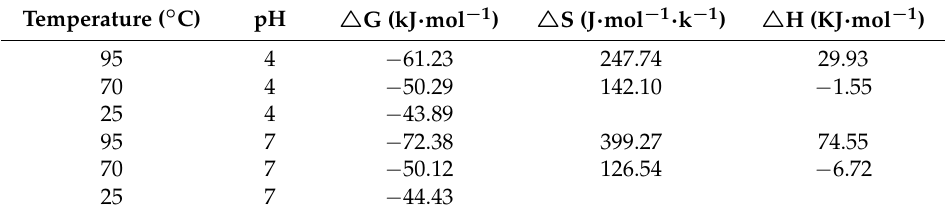
Table 3. The thermodynamic parameters for the binding of LF and CA at pH 4 and pH 7. Temperature ( ◦